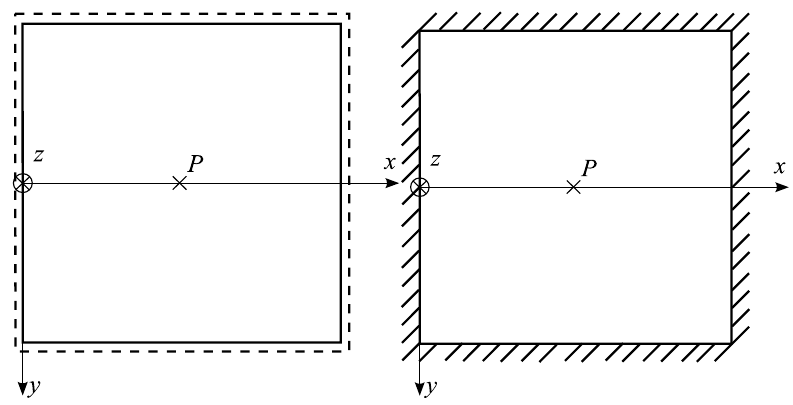
Figure 4. Plates taken for convergence analysis: simply supported and clamped with concentrated load in the middle.